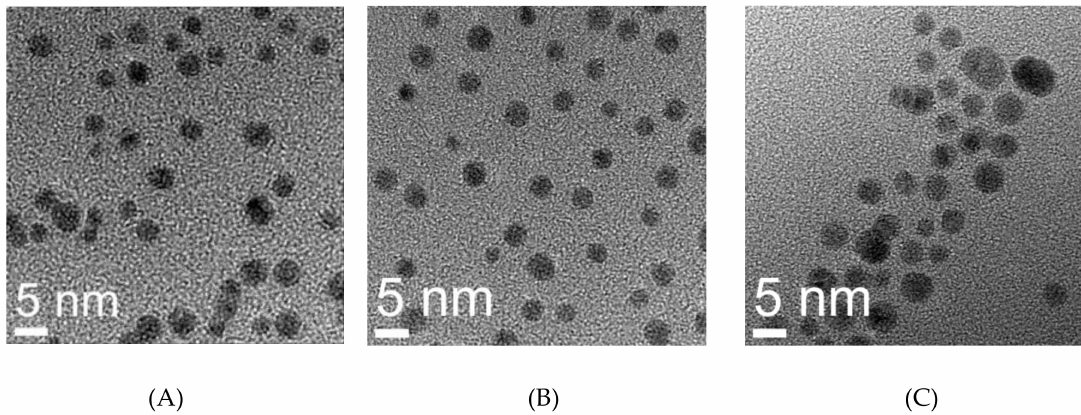
Figure 3. TEM images of ( A ) GNP-Gd-DO3A-SH-AS1411, ( B ) GNP-Gd-DO3A-SH-CRO, and ( C )